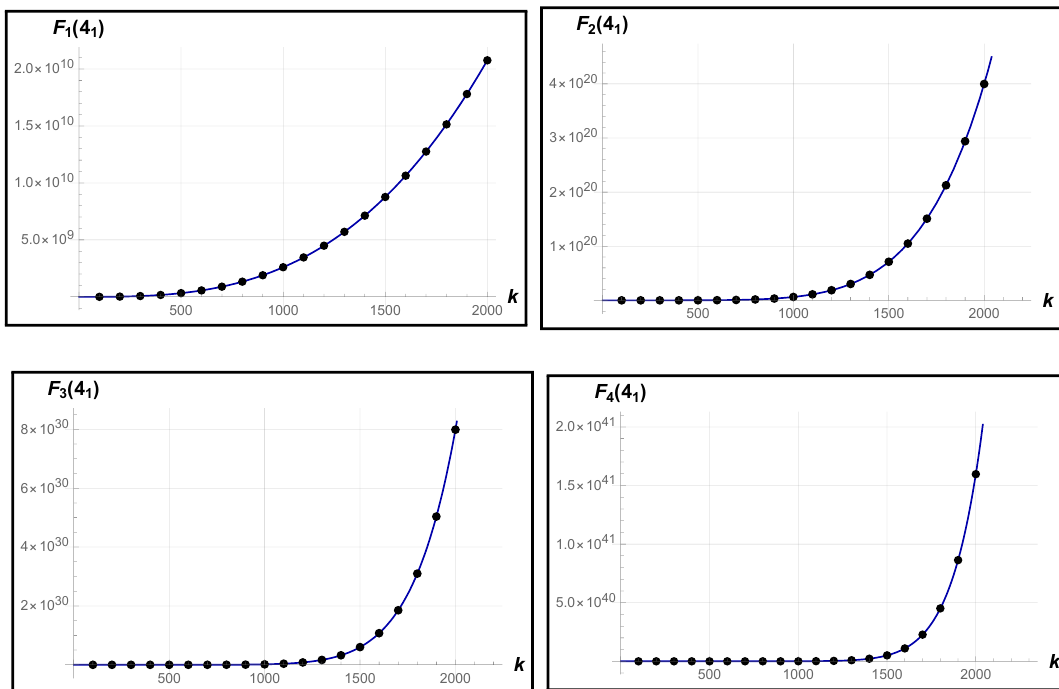
Figure 11. The variation of the function F m with k for 4 1 knot. The solid line denotes the function C m k 3 m with values of C m given in table 6. The • indicates the numerical values of F m obtained from explicit computations.